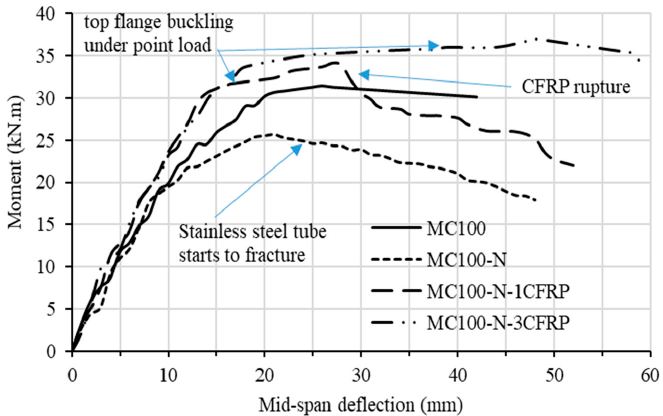
Figure 12. Moment vs. mid-span deflection relationships of the CFRP strengthened RCFSST speci- mens.